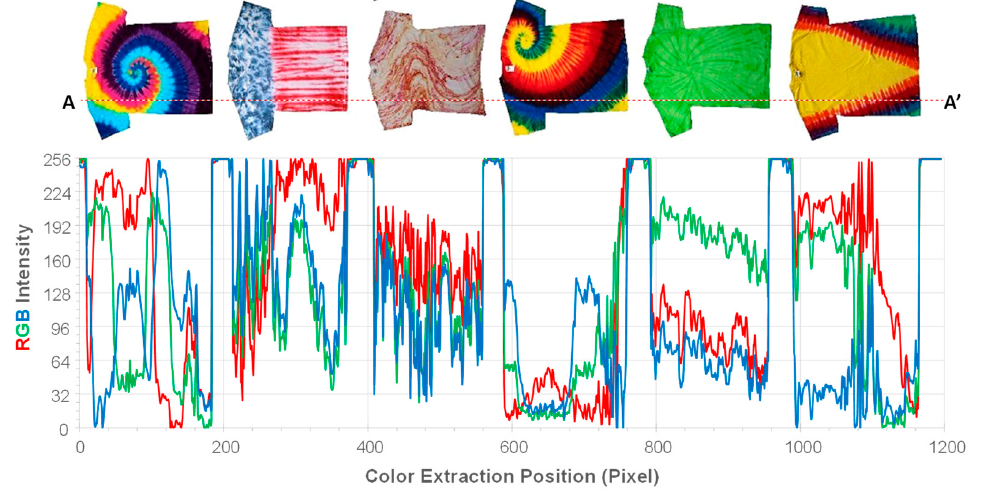
Figure 4. Examples of color information extraction of individual pixels across the line A-A’ on six dyed T-shirt images in the left column of Figure 1.